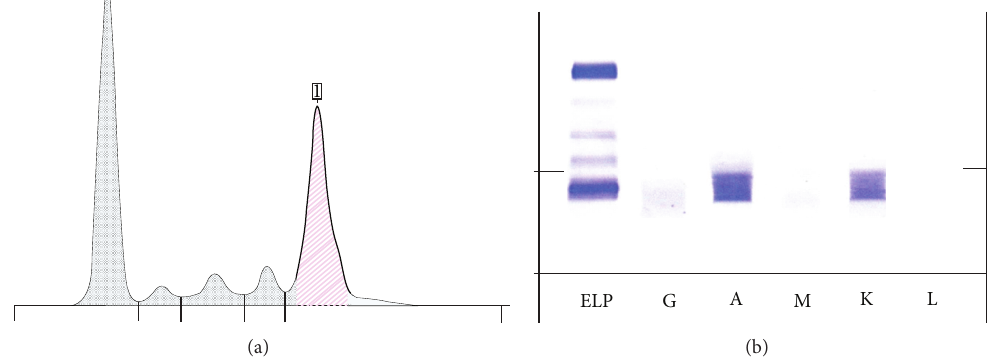
Figure 1: Protein electrophoresis. (a) Monoclonal peak in the Gamma zone. (b) IgA Kappa